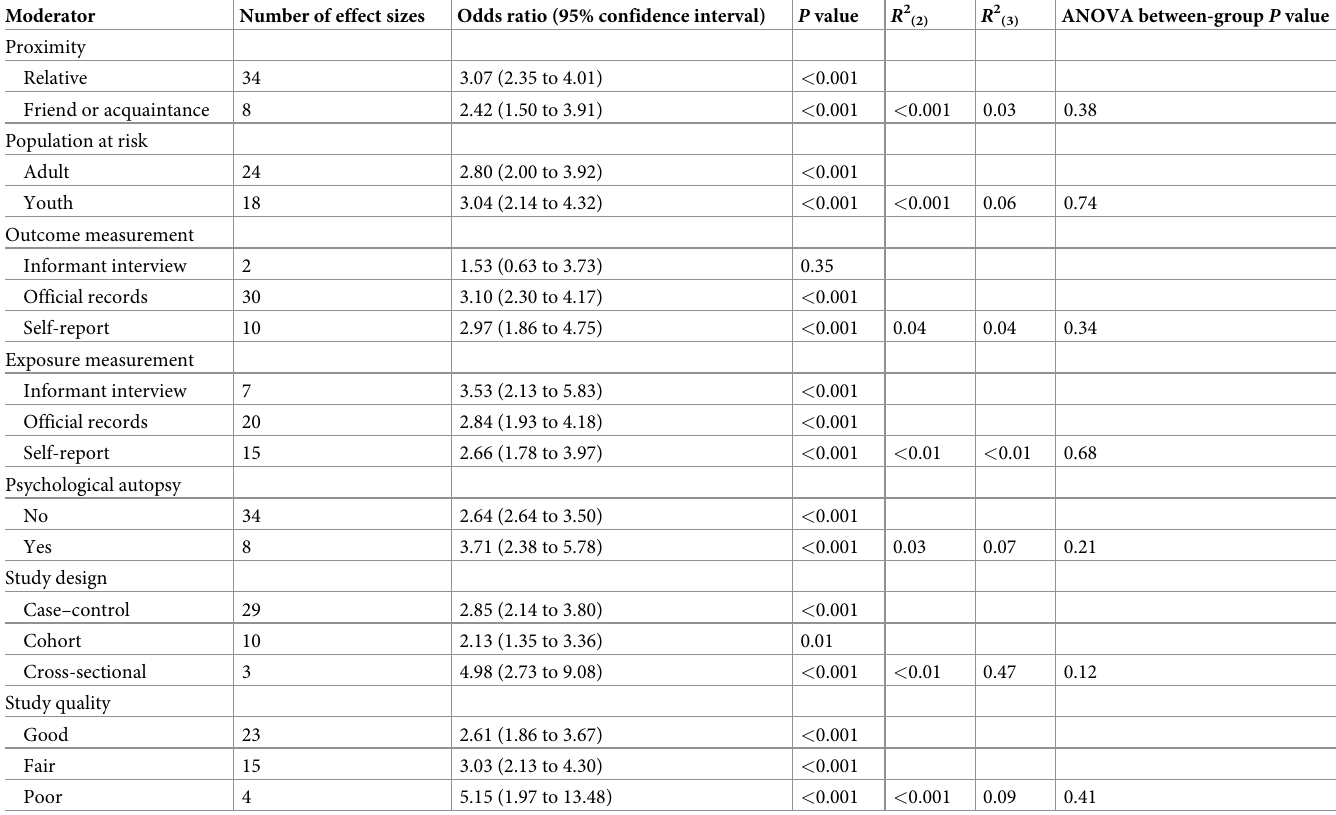
Table 2. Results of moderator analyses of exposure to suicide across suicide, suicide attempt, and suicidal ideation